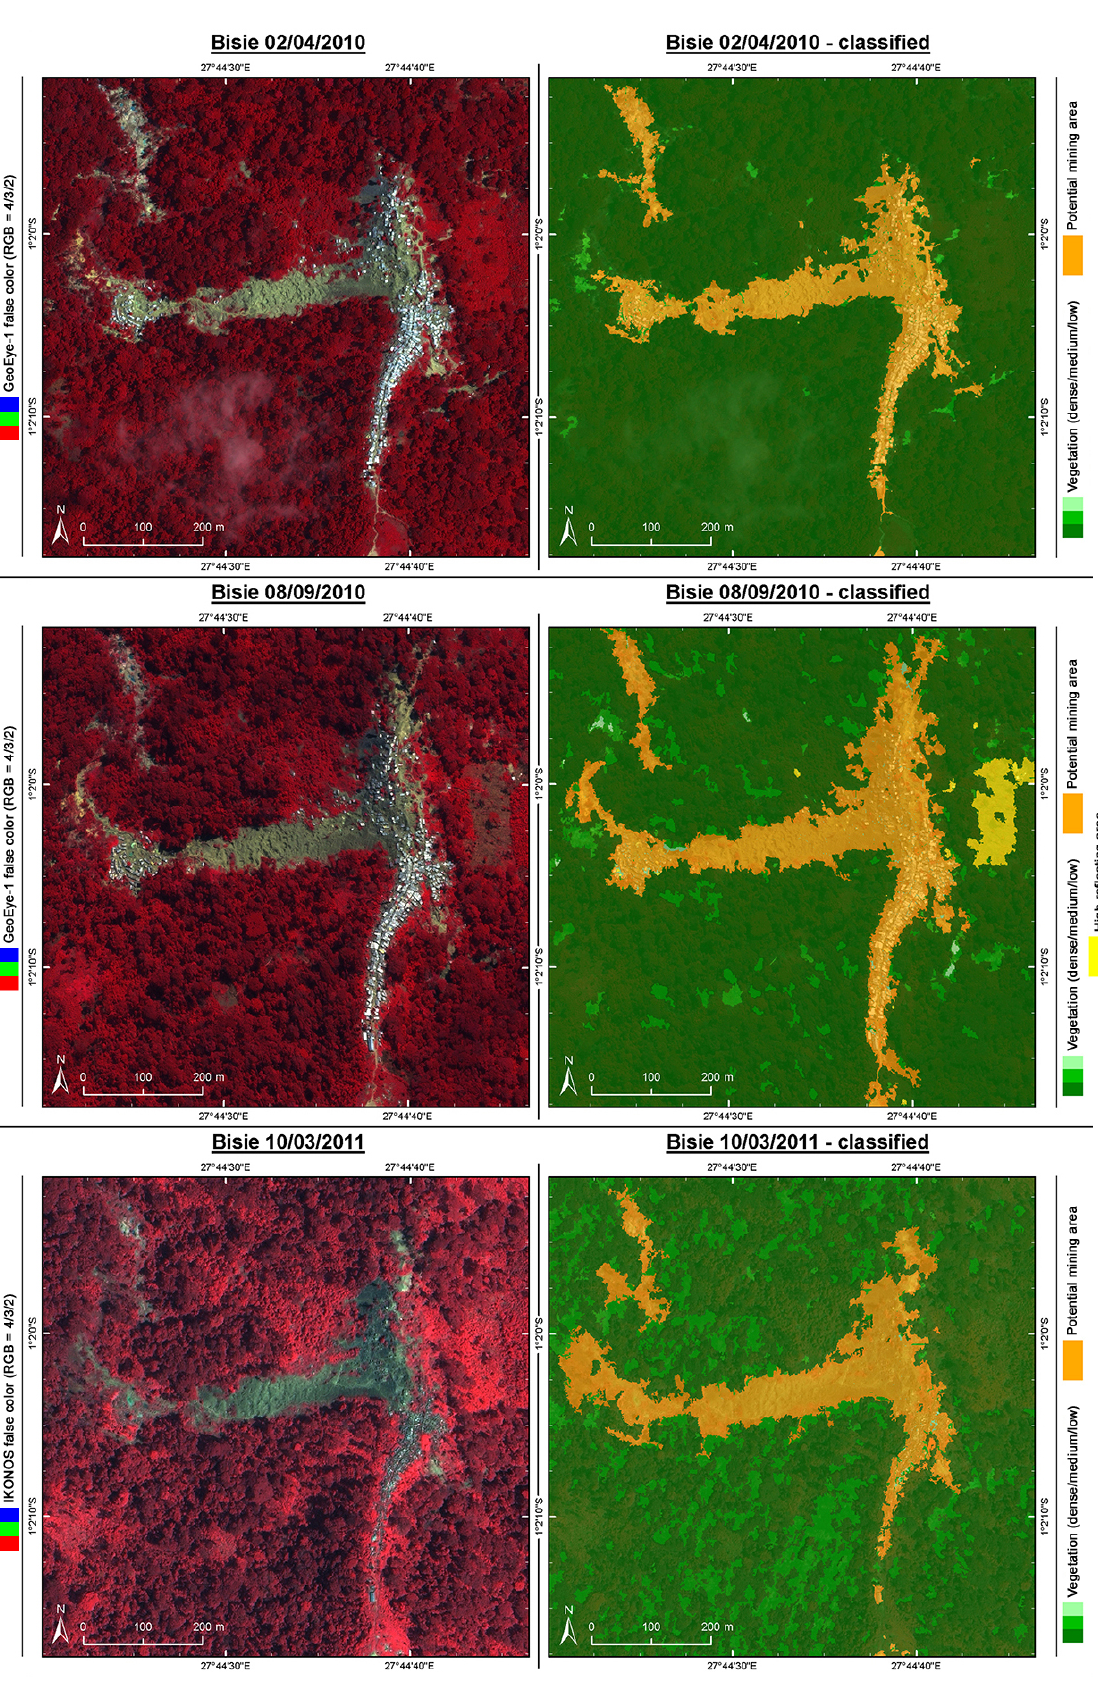
Figure 10. Comparison of unclassified ( left ) and classified ( right ) imagery of